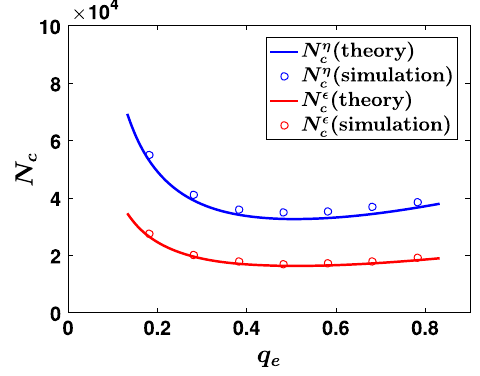
stages.FIG. 4. Simulated vs theoretical cooling